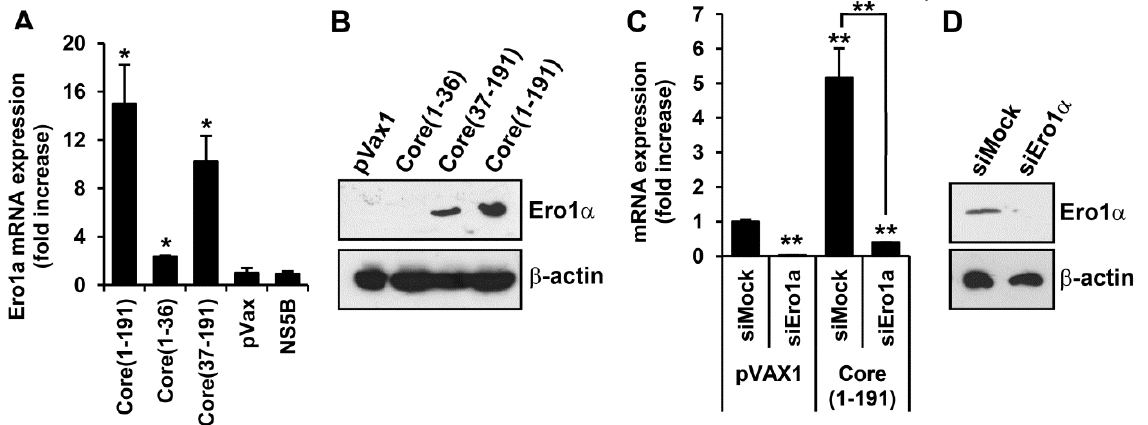
Figure 5. Cont . Figure 5. Cont